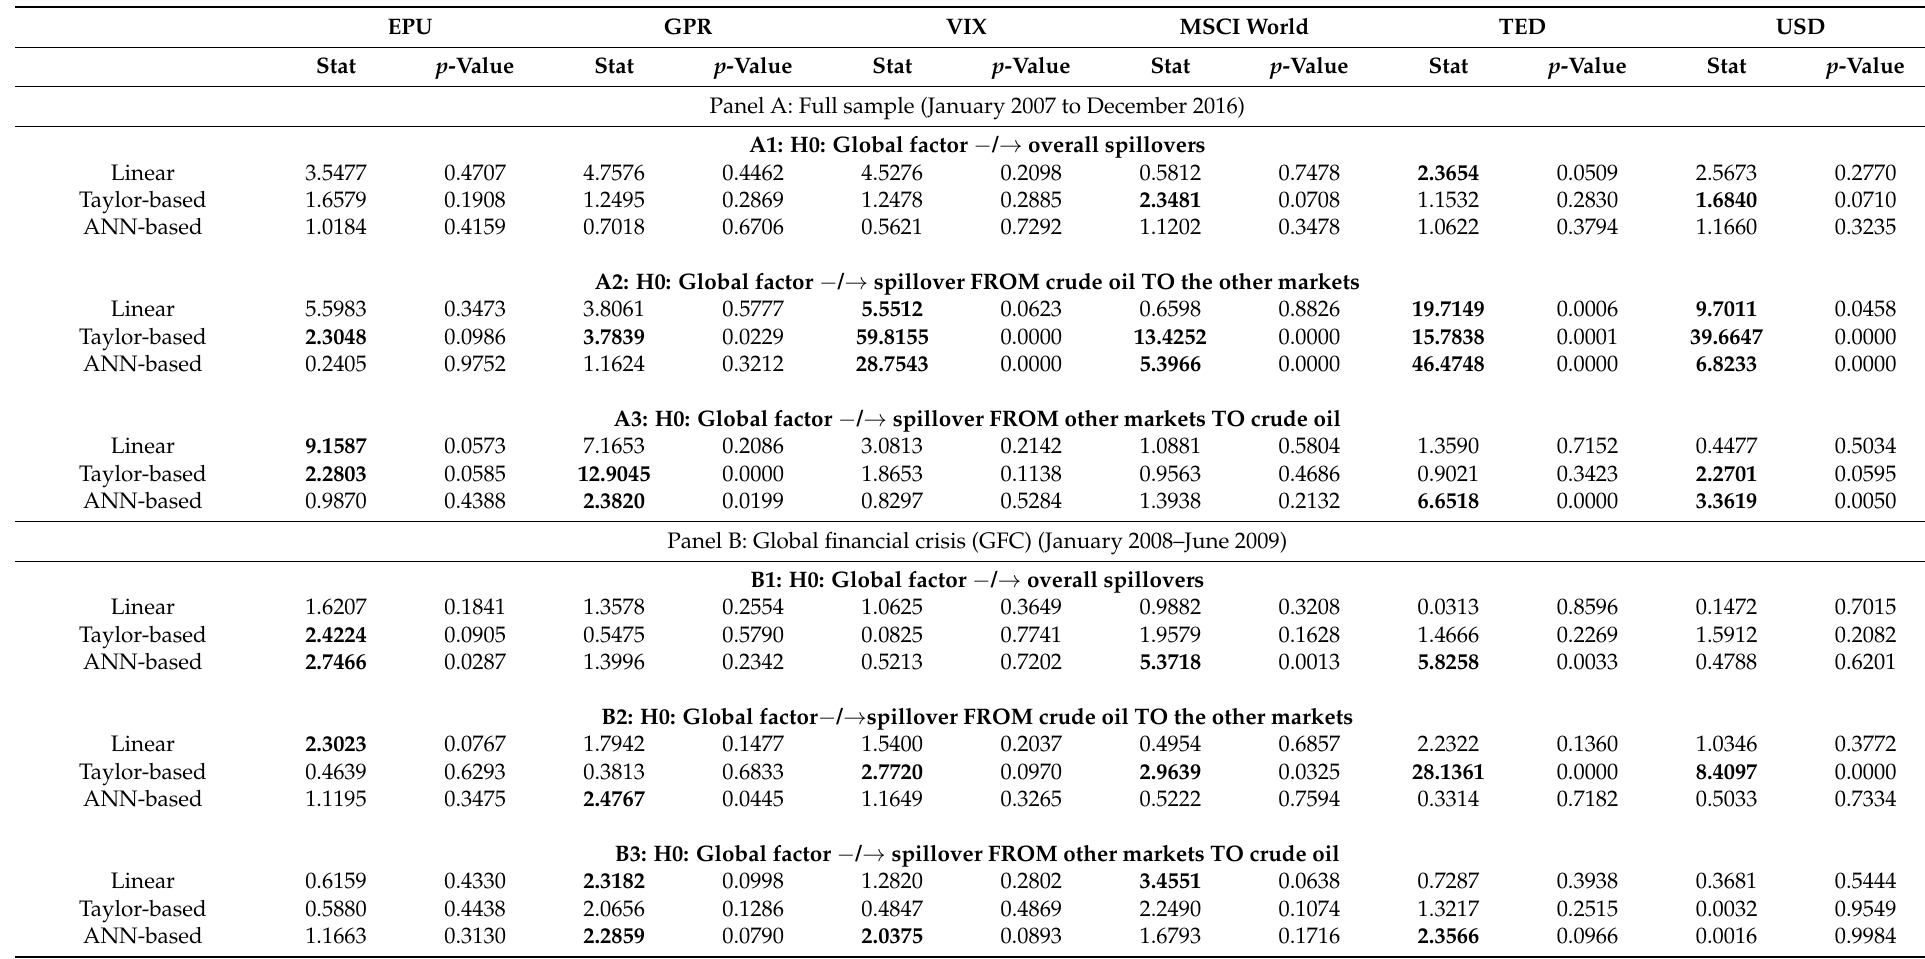
Table 3. Linear and nonlinear causality tests for overall and unidirectional